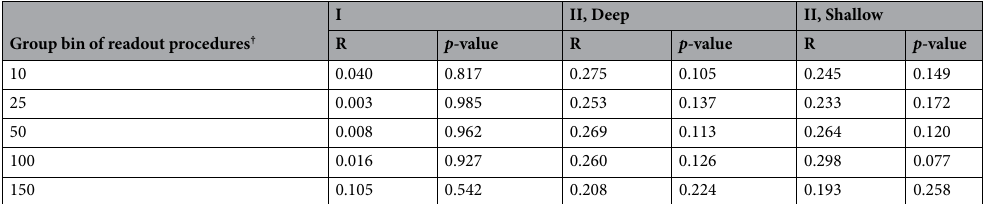
Table 4. The results of linear-regression between the frequency of readout procedure and dose deviation within three irradiation categories. † The group of readout procedure was based on how many times of readout procedures which was chosen for one